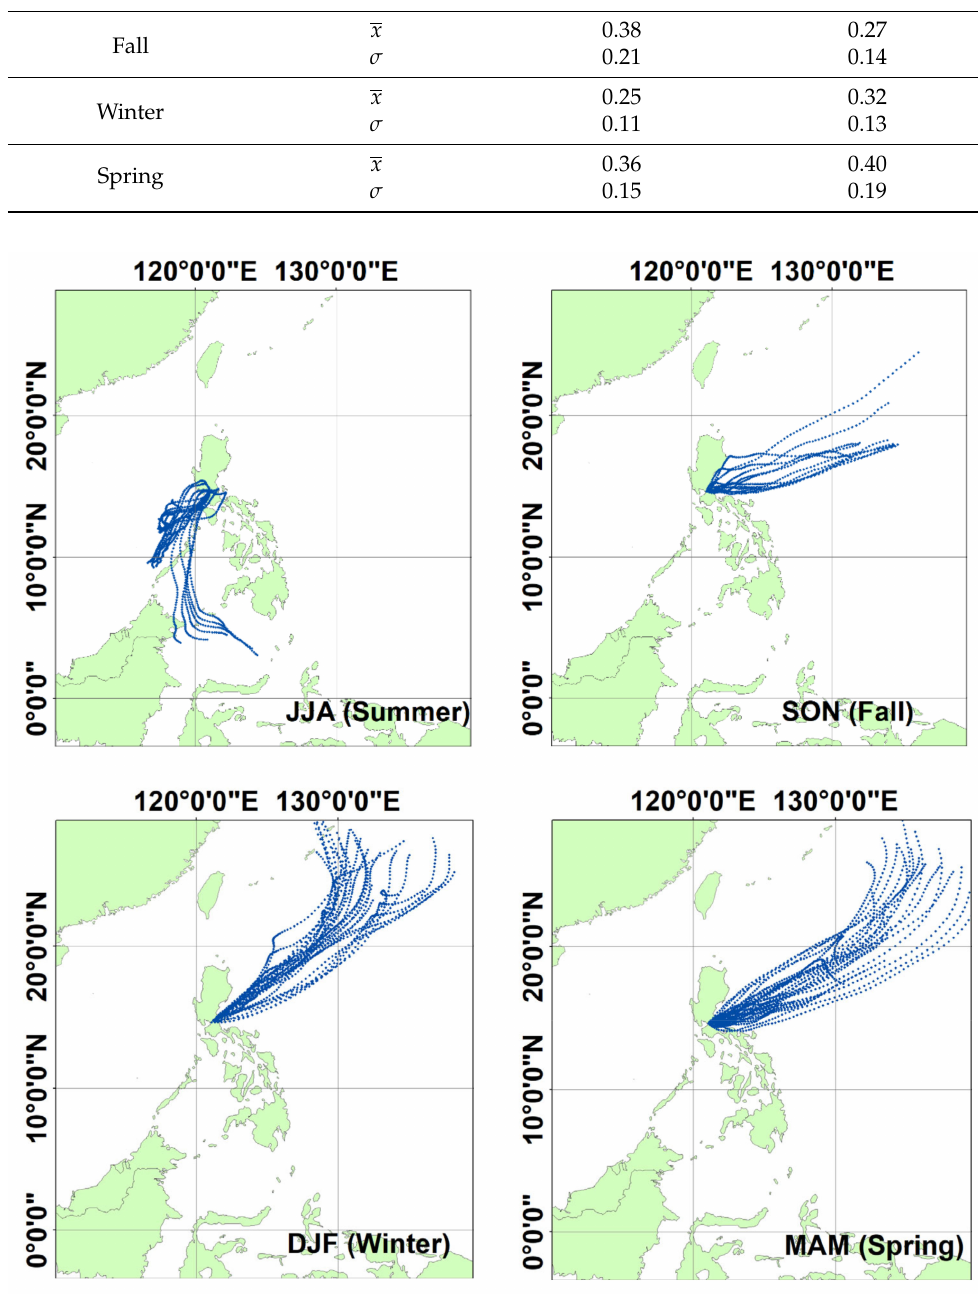
Figure 8. Cluster analysis of 72 h HYSPLIT-NCEP/NCAR wind back-trajectories arriving every 6 h for each season in Quezon